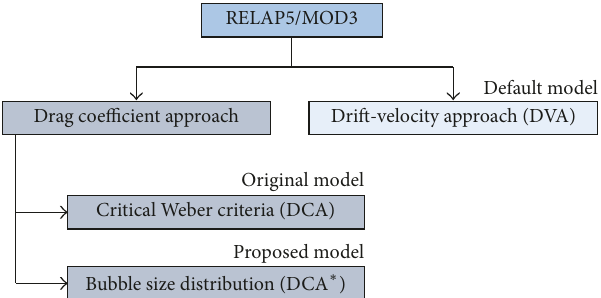
Figure 1: General overview of the drag force term approaches used in this work.